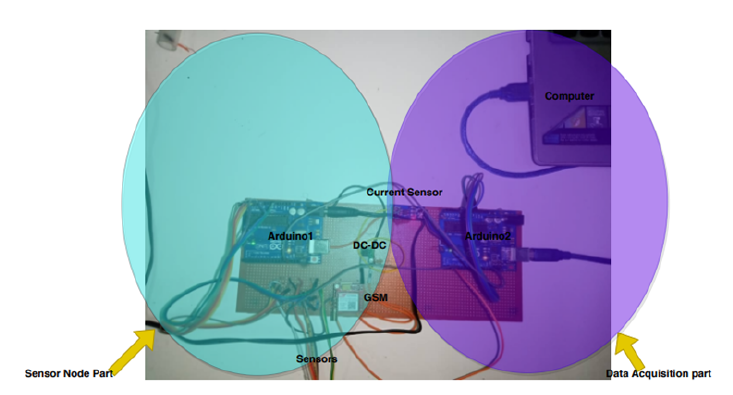
Figure 6. The picture for the